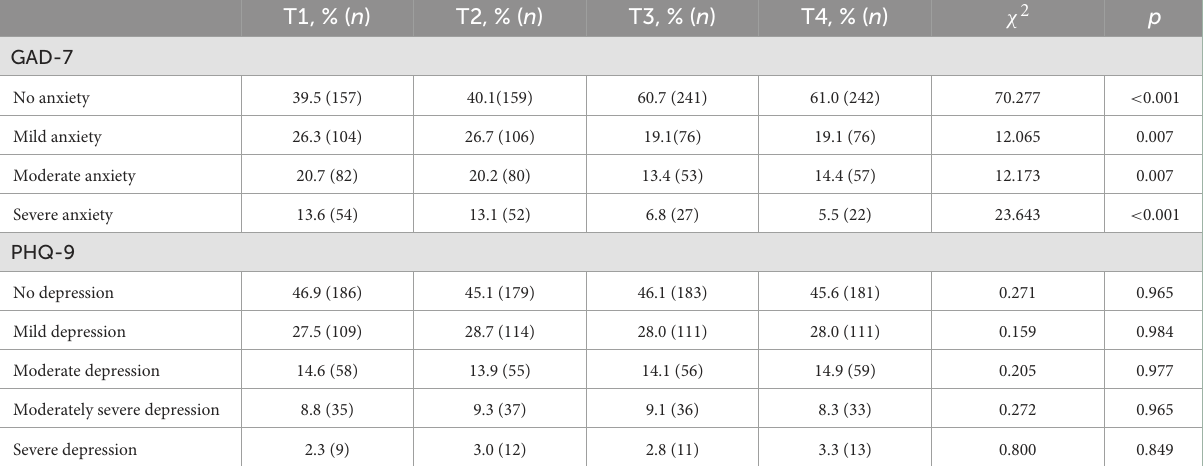
TABLE 3 Chi-squared test: the rates of different degrees of anxiety and depression symptoms among different time points. T1, % ( n ) T2, % ( n ) T3, % ( n ) T4, % ( n ) χ